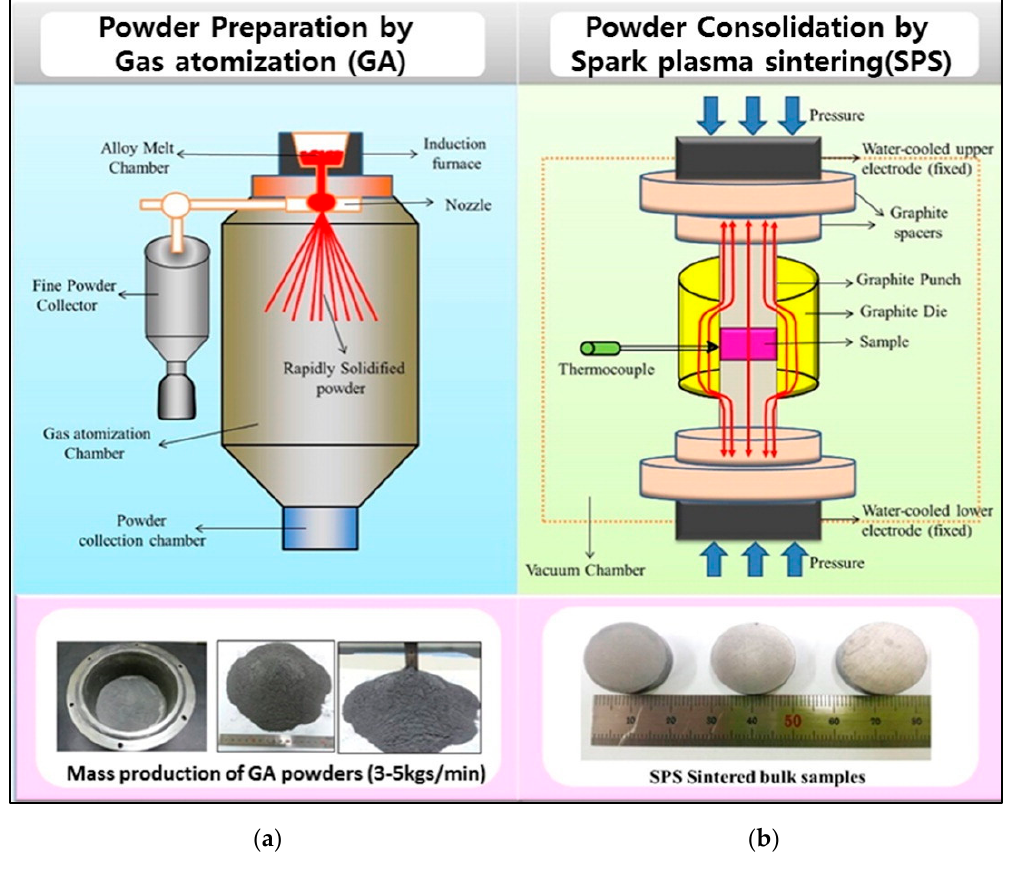
Figure 5. ( a ) Large-scale synthesis of Bi-Sb-Te alloys powder (bismuth antimony telluride) by gas atomization (GA) (3–5 kg/min) (synthesized Bi 2 Te 3 + 75%Sb 2 Te 3 powder can also be seen). ( b ) Spark plasma sintering (SPS) is used to consolidate the resultant nanopowder (the spark plasma sintered bulk samples can also be seen). Reproduced with permission from [19]. Copyright Elsevier, 2016.